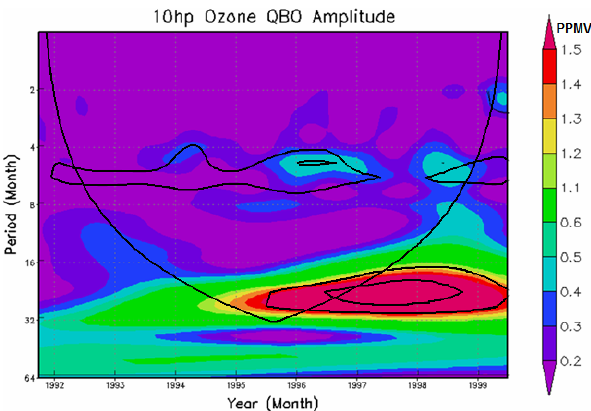
Fig. 2. Variation of amplitude of ozone QBO with time over 0– 10 ◦ N latitudinal belt, thick closed contour indicate 95% signifi- cance levels and U-shape curve indicate Cone Of Influence